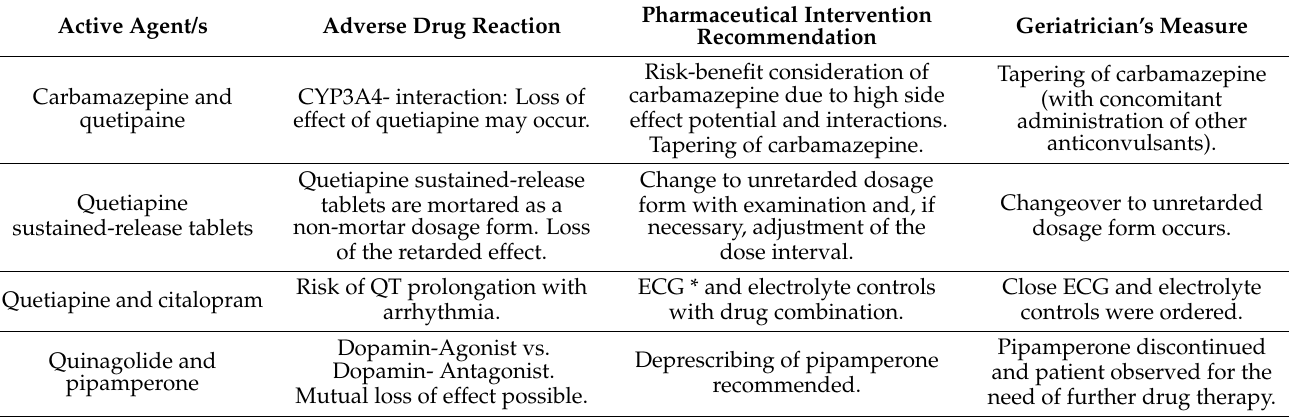
Table 7. Examples of potential adverse drug reactions, the pharmaceutical intervention recommenda- tion, and the geriatrician’s